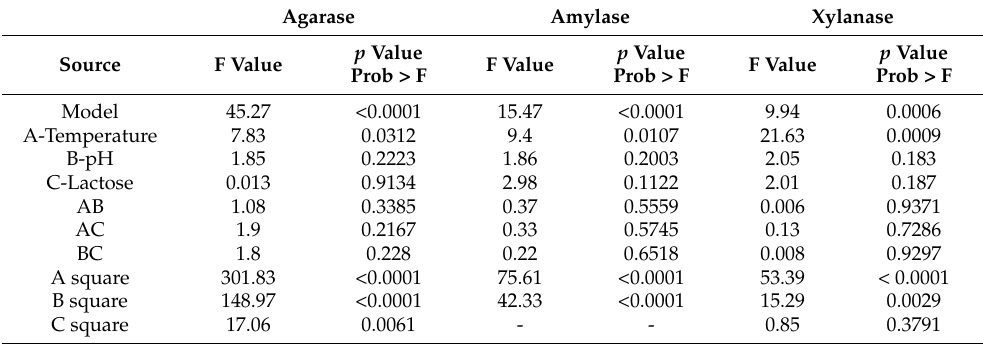
Table 3. Concise ANOVA